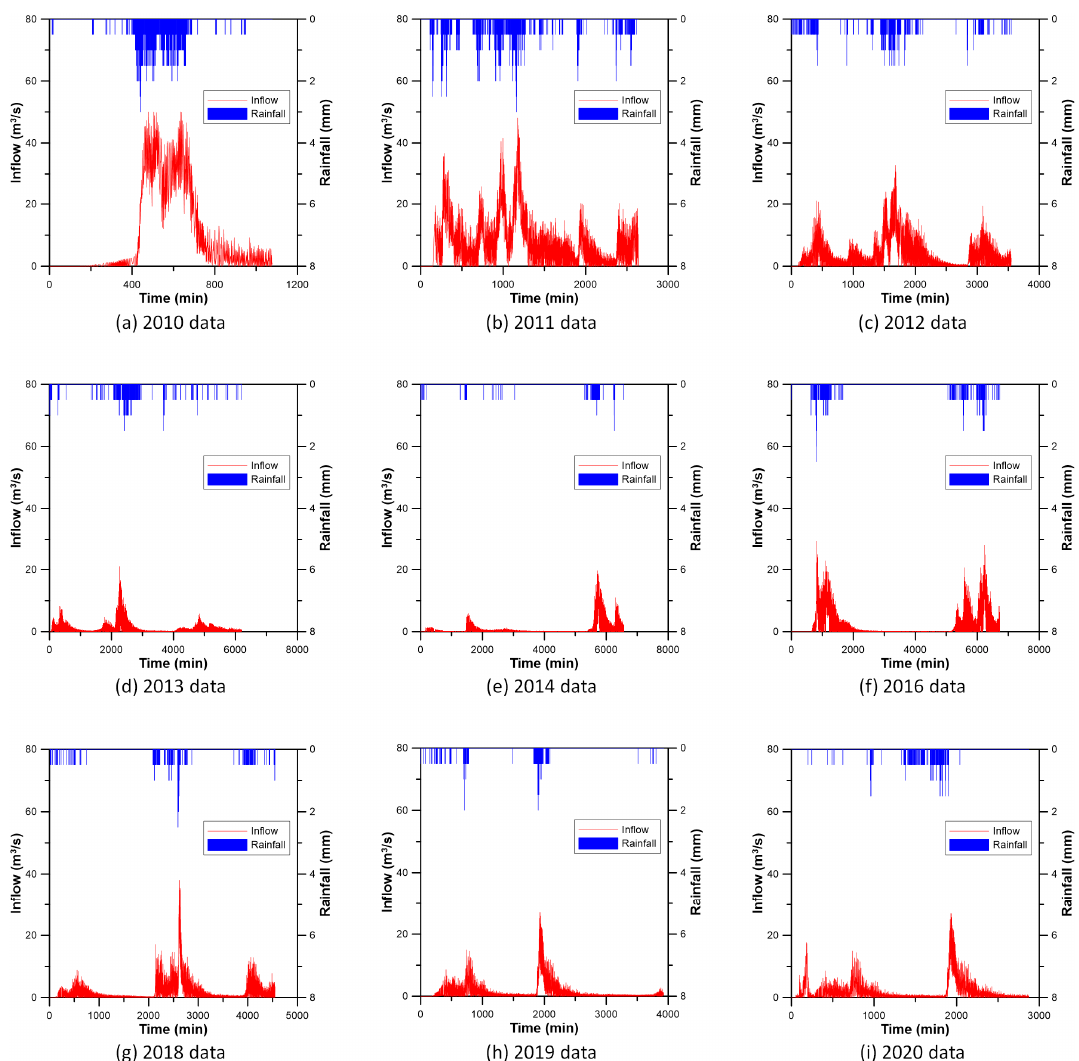
Figure 6. Observed rainfall and inflow of CR within the study area. Table 2. Results of maximum flooding nodes.